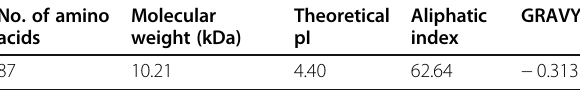
Table 1 Physicochemical characterization of